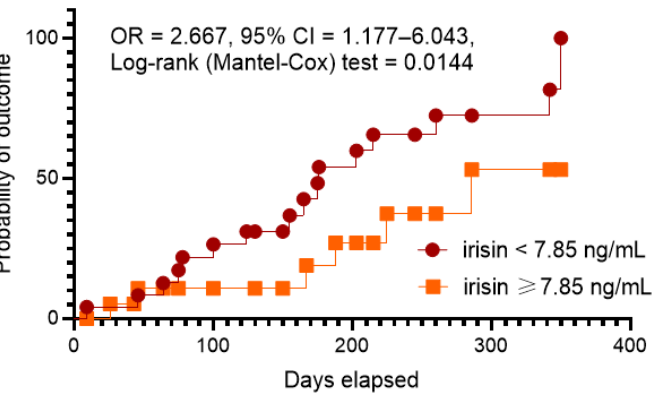
Figure 3. The Kaplan–Meier analysis of ADHF. Abbreviations: AUC, area under curve; CI, con fi - dence interval; OR, odds